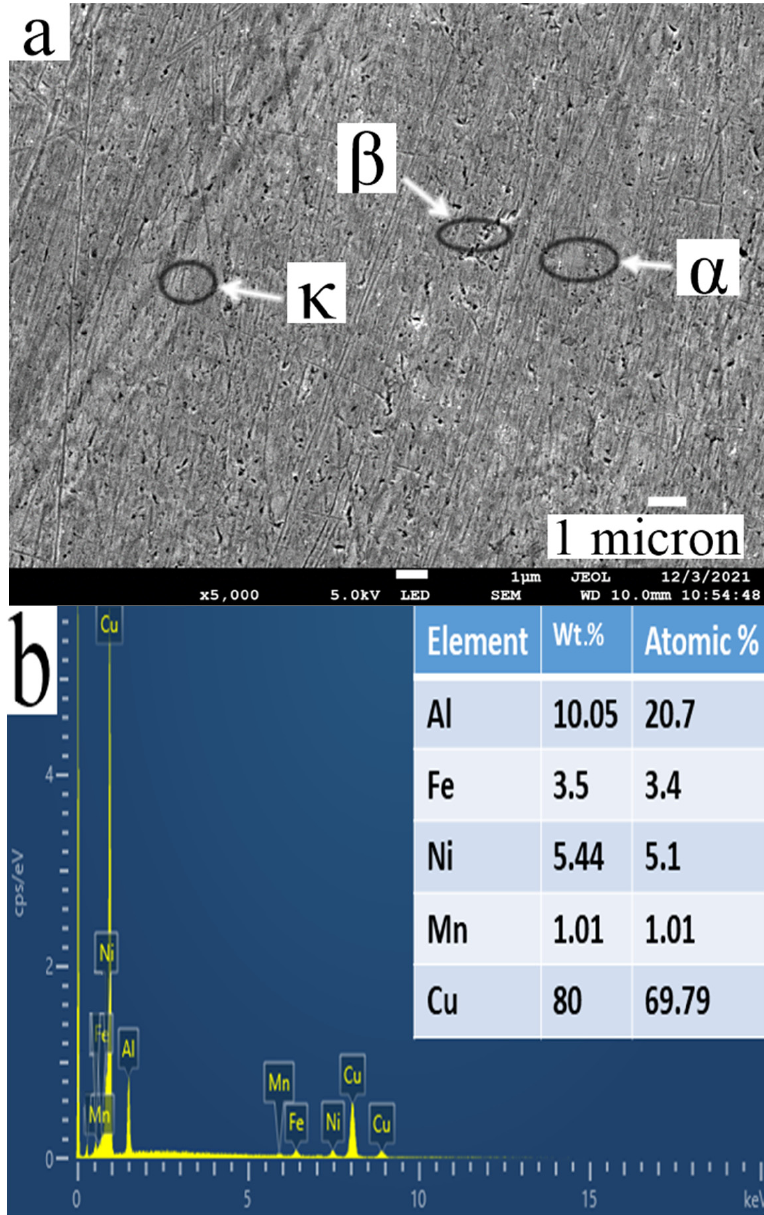
Figure 7. ( a ) FE-SEM image of as-cast NAB and ( b ) EDS image of as-cast NAB.